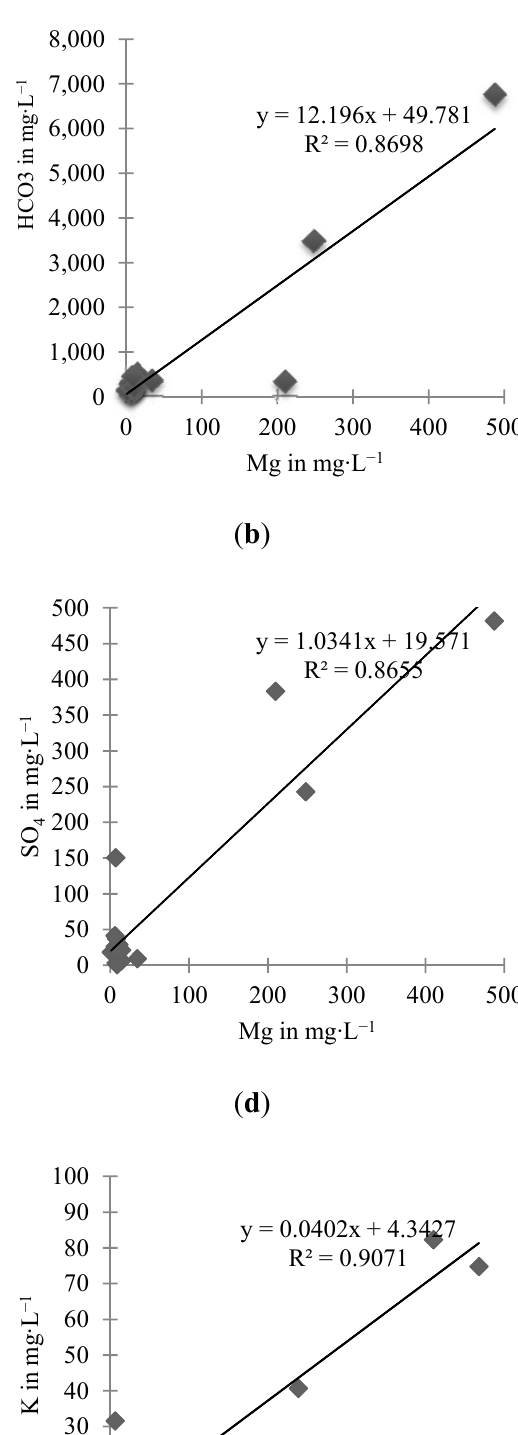
Figure 2. Bivariate linear graphs of the most significant parameters at p <